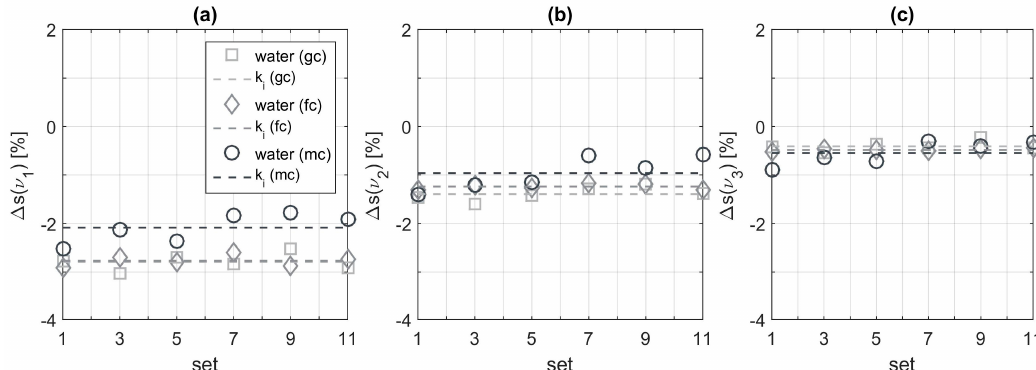
Sensors 2019 , 19 FOR PEER REVIEW